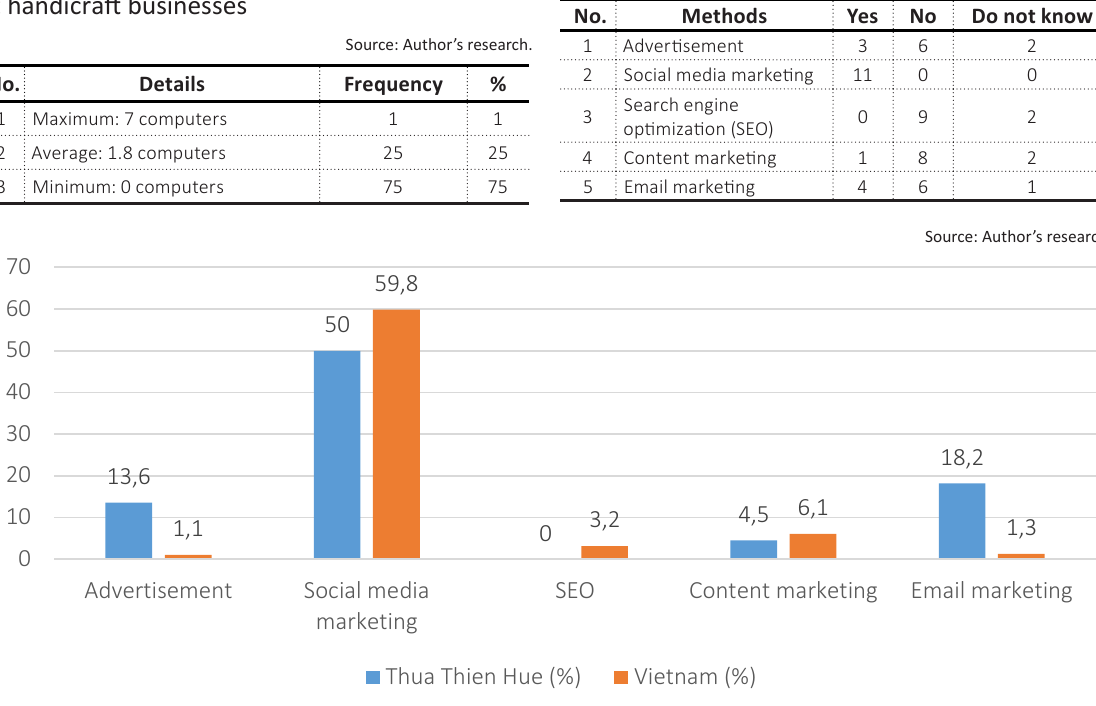
Table 1. Overview of number of computers at handicraft businesses